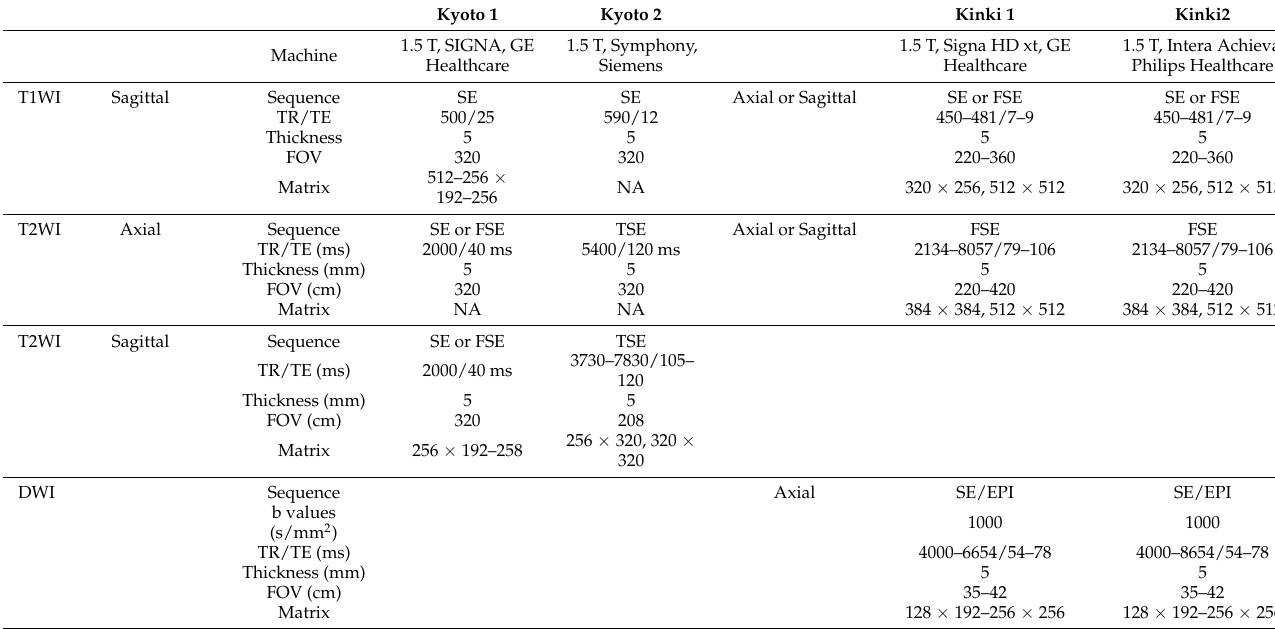
Table 1. Magnetic resonance imaging